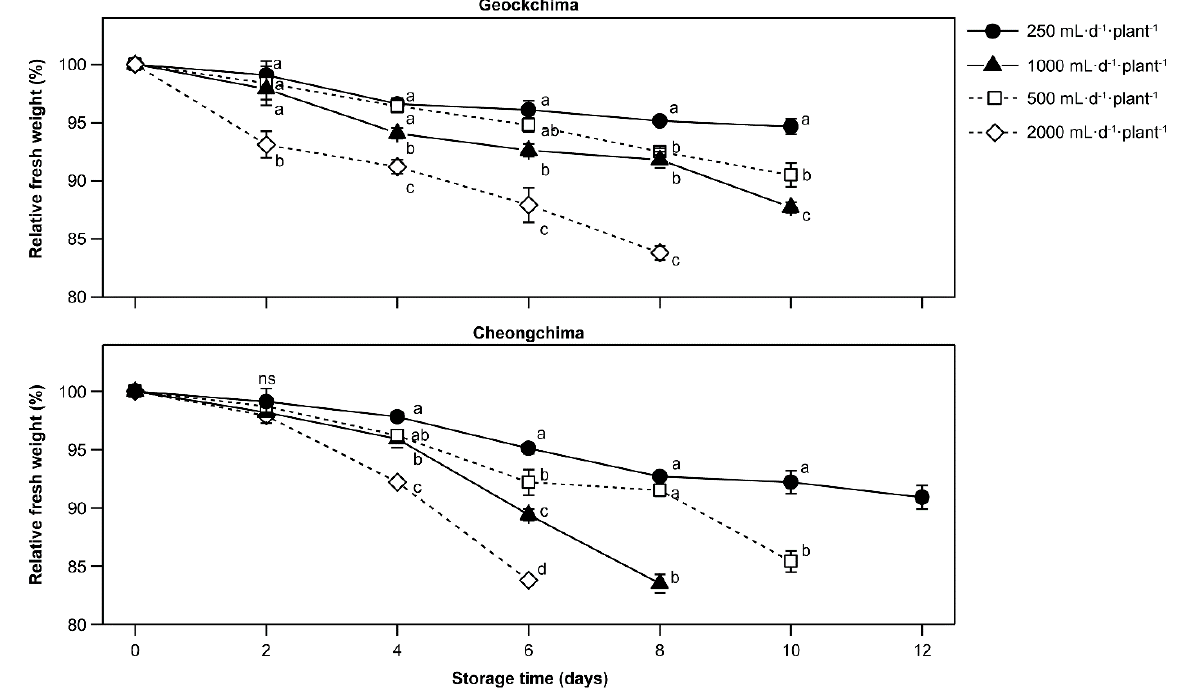
Figure 2. Effect of the amount of nutrient solution on relative fresh weight of leaf lettuce cultivars Geockchima and Cheongchima during storage at 7 °C. Mean values at each evaluation day with different lowercase letters are significantly different according to Duncan’s multiple range test ( p ≤ 0.05), ns = non-significant.